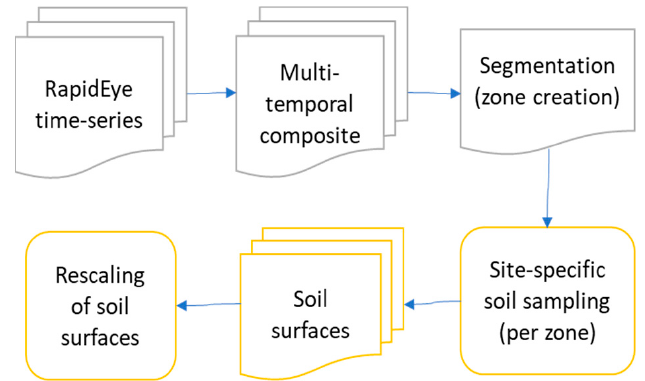
Figure 3. Analysis overview; from image segmentation to multi-scale soil mapping.